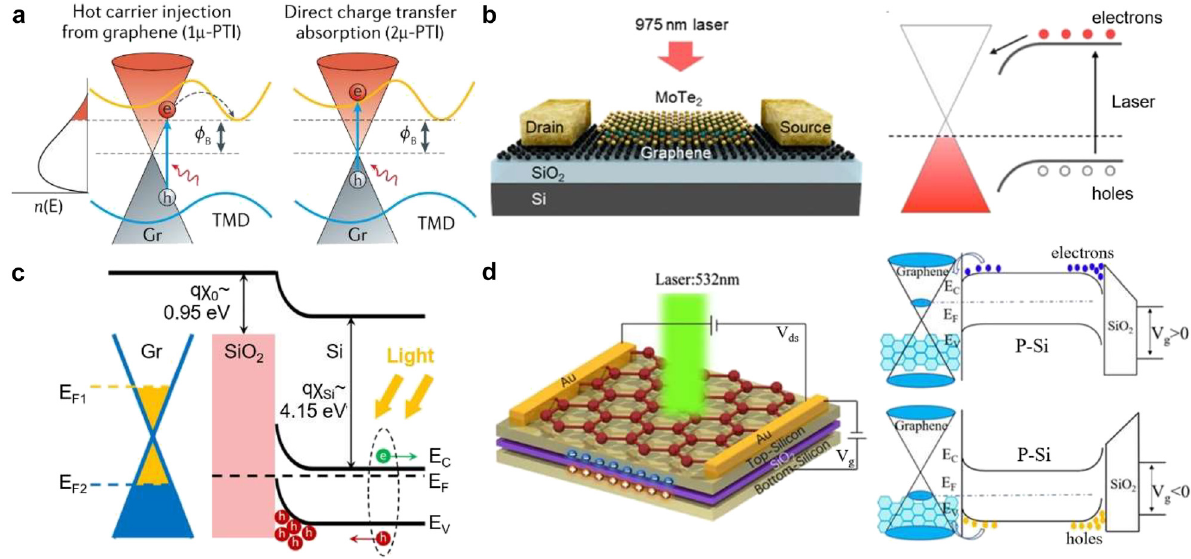
Figure 5: Photo-modulation processes of graphene-based heterojunctions. (a)Schematicrepresentationofbanddiagramsforthetwokindsofphoto-thermionicchargetransferprocessesinagraphene/TMDheterostructure: (left) 1 μ -PTI, (right) 2 μ -PTI. The red shaded area is the distribution of ultrafast thermalized HCs, Φ B is the Schottky barrier between graphene and TMDs [70]. (b) Graphene/MoTe 2 photodevice where bands of MoTe 2 bends upon the contact with graphene, creating a large-area 2D interface with facilitatedelectroninjectiontographene.Adaptedwithpermissionfrom[89,p.2].(c)EnergybandalignmentofgrapheneonSi/SiO 2 substrate.The band bending at the Si/SiO 2 interface induces electron – hole pairs separation. Under the gate bias, electrons (green) diffuse into the Si bulk, while holes (red) are trapped at the Si/SiO 2 interface. The accumulation of photo-generated holes at the interface acts as an additional gate bias, increasing the Fermi level in graphene and its n-type doping. Adapted with permission from [94]. (d) (Left) Schematic of the graphene/silicon-on- insulator heterojunction device in photoconductive mode. (Right) Energy band diagrams of the photodetector under positive (top) and negative (bottom) vertical voltage showing opposite sign of the photogating in graphene. Adapted with permission from